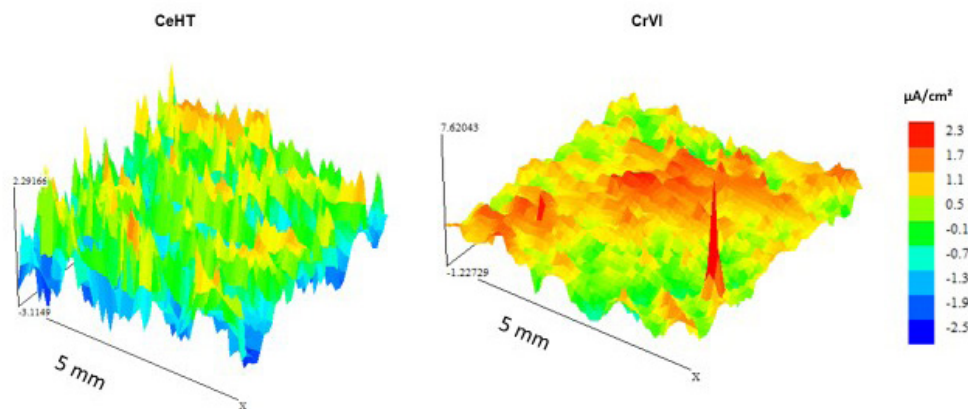
Figure 5. 3D SVET maps obtained for AA1230 clad on AA2024 alloy with various after CeHT and CrVI treatments. Measurements obtained after 6 h of exposure in NaCl 0.05 mol L -1 .